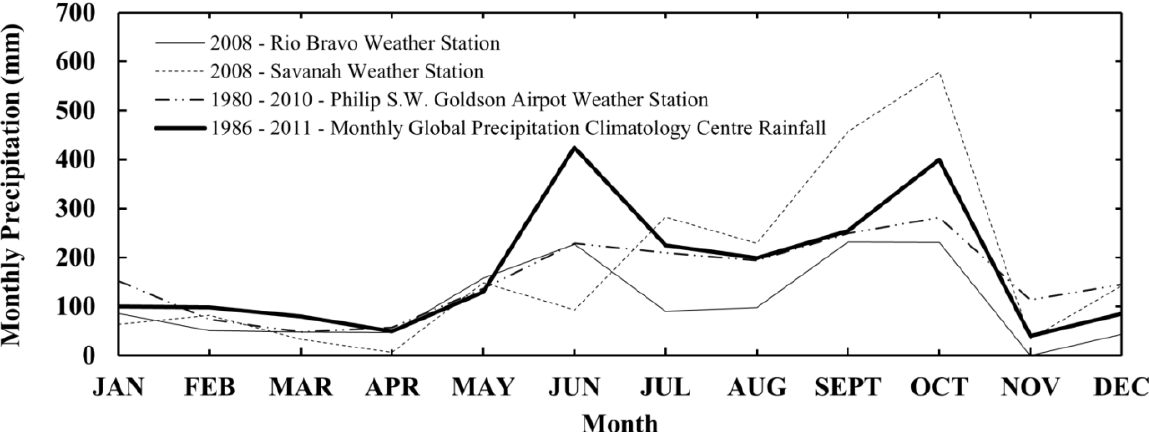
Figure 3. Illustrating the wet and dry seasonality in Belize; two major precipitation spikes are observed in June and October, while September also appears to be a rainy